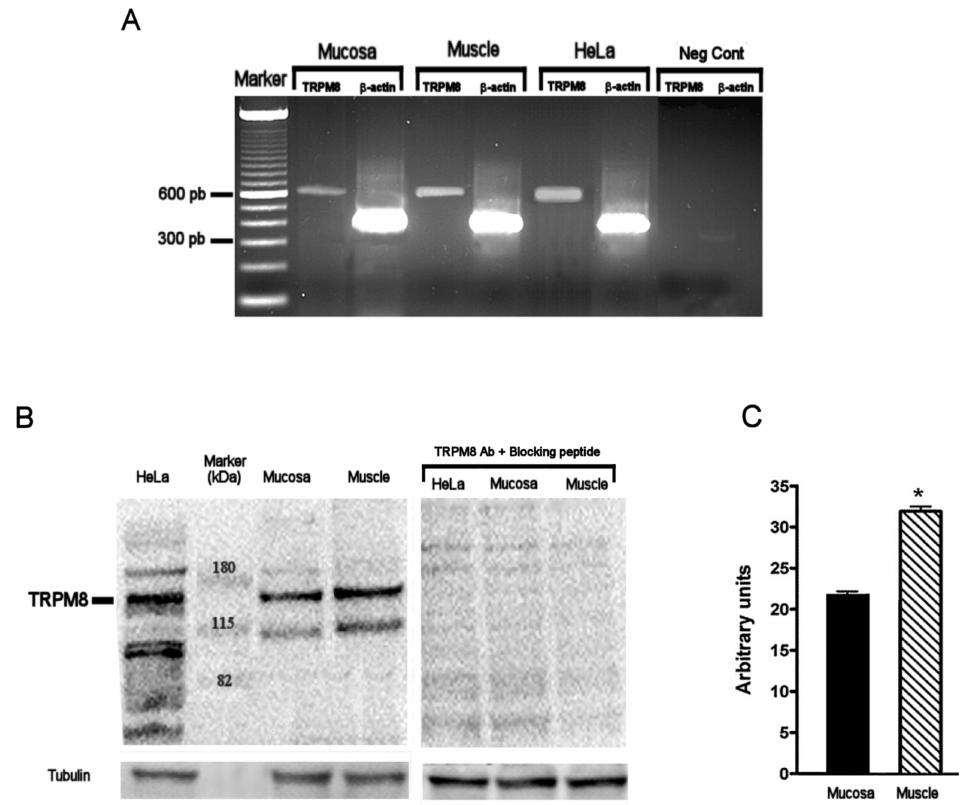
Figure 1. TRPM8 mRNA and protein expression in human distal colon. ( A ) Representative images of the reverse transcriptase-polymerase chain reaction (RT-PCR) results. A product of 621 bp corresponding to TRPM8 was detected in mucosa, smooth muscle, and HeLa cells used as positive control. The expression of β -actin (396 bp) was used as loading control. Negative control was obtained without addition of cDNA. ( B ) Western blot detecting protein levels for TRPM8 from colon mucosa and muscle. ( C ) Densitometric analysis of blots was performed using the NIH Image J 1.40 analysis program. HeLa cells were used as positive control. Human tubulin was used as loading control. Negative control was obtained by using blocking peptide added to TRPM8 Ab. n = 6; * p < 0.05 when compared to TRPM8 mucosa